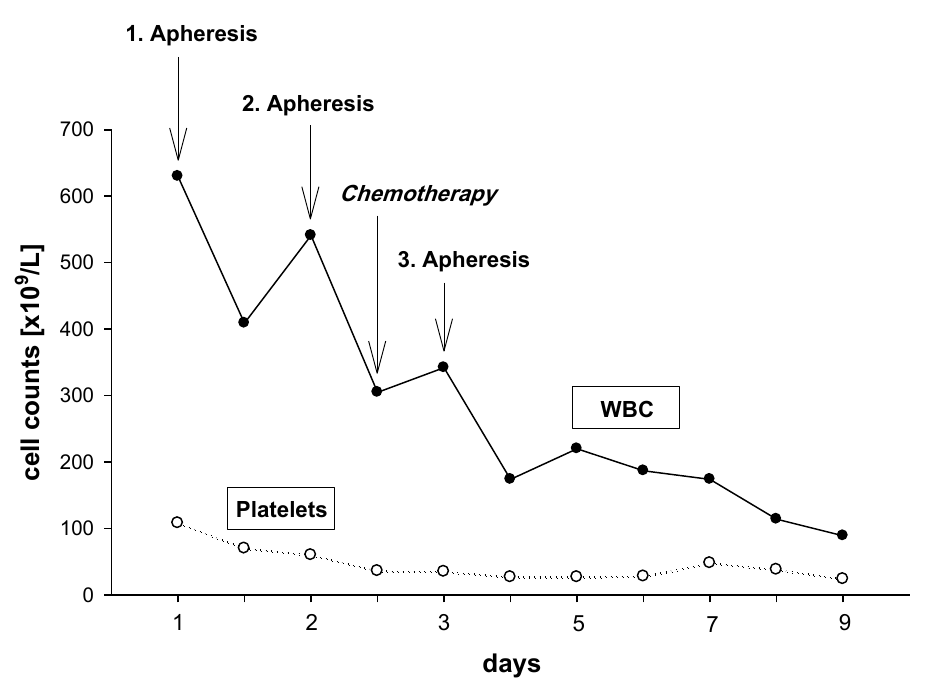
FIGURE 2. WBC count and PLT over time. The patient underwent three sessions of leukapheresis. Chemotherapy with vincristine, cyclophosphamide, and prednisolone was started after the second